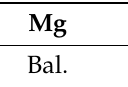
Table 1. Chemical compositions of the Mg–3CaMgSn master alloy